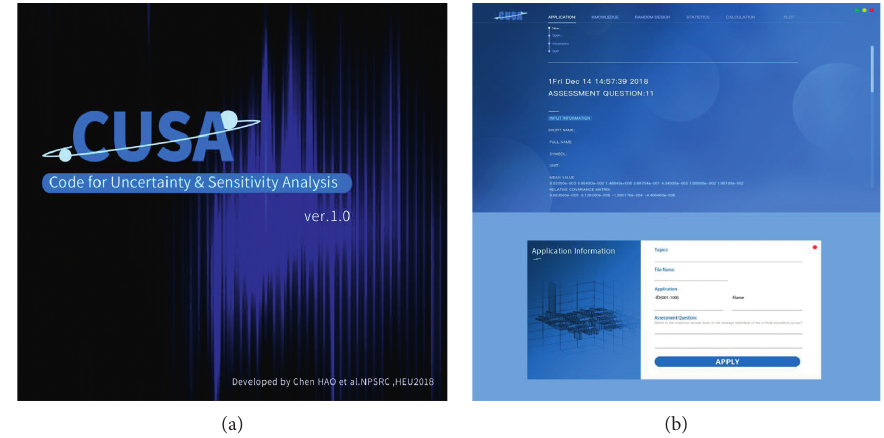
Figure 3: Initial and operation interface of CUSA.